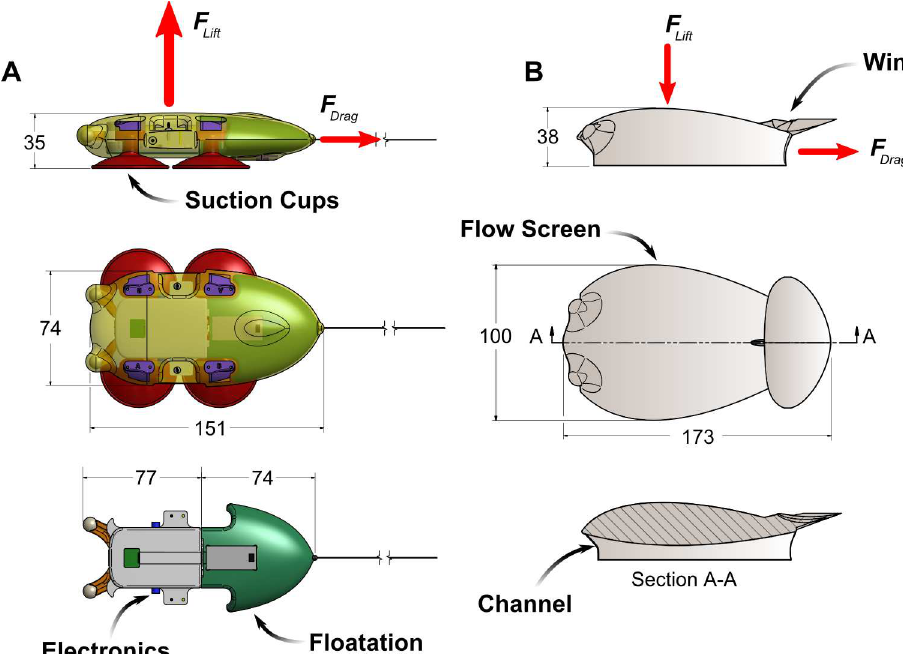
Fig 1. (A) A representative illustrationof the Model 0 tag with a foil-like cross section. As swimming speed increases,the lift generatedby this housingshapebecomes the dominant force acting on the tag. The tag componentsthat drive the packagingconstraint are shown in the bottom left. (B) Illustration of a tag with a flow screen, wing and underbodychanneldesignedto reducethe lift force acting on the